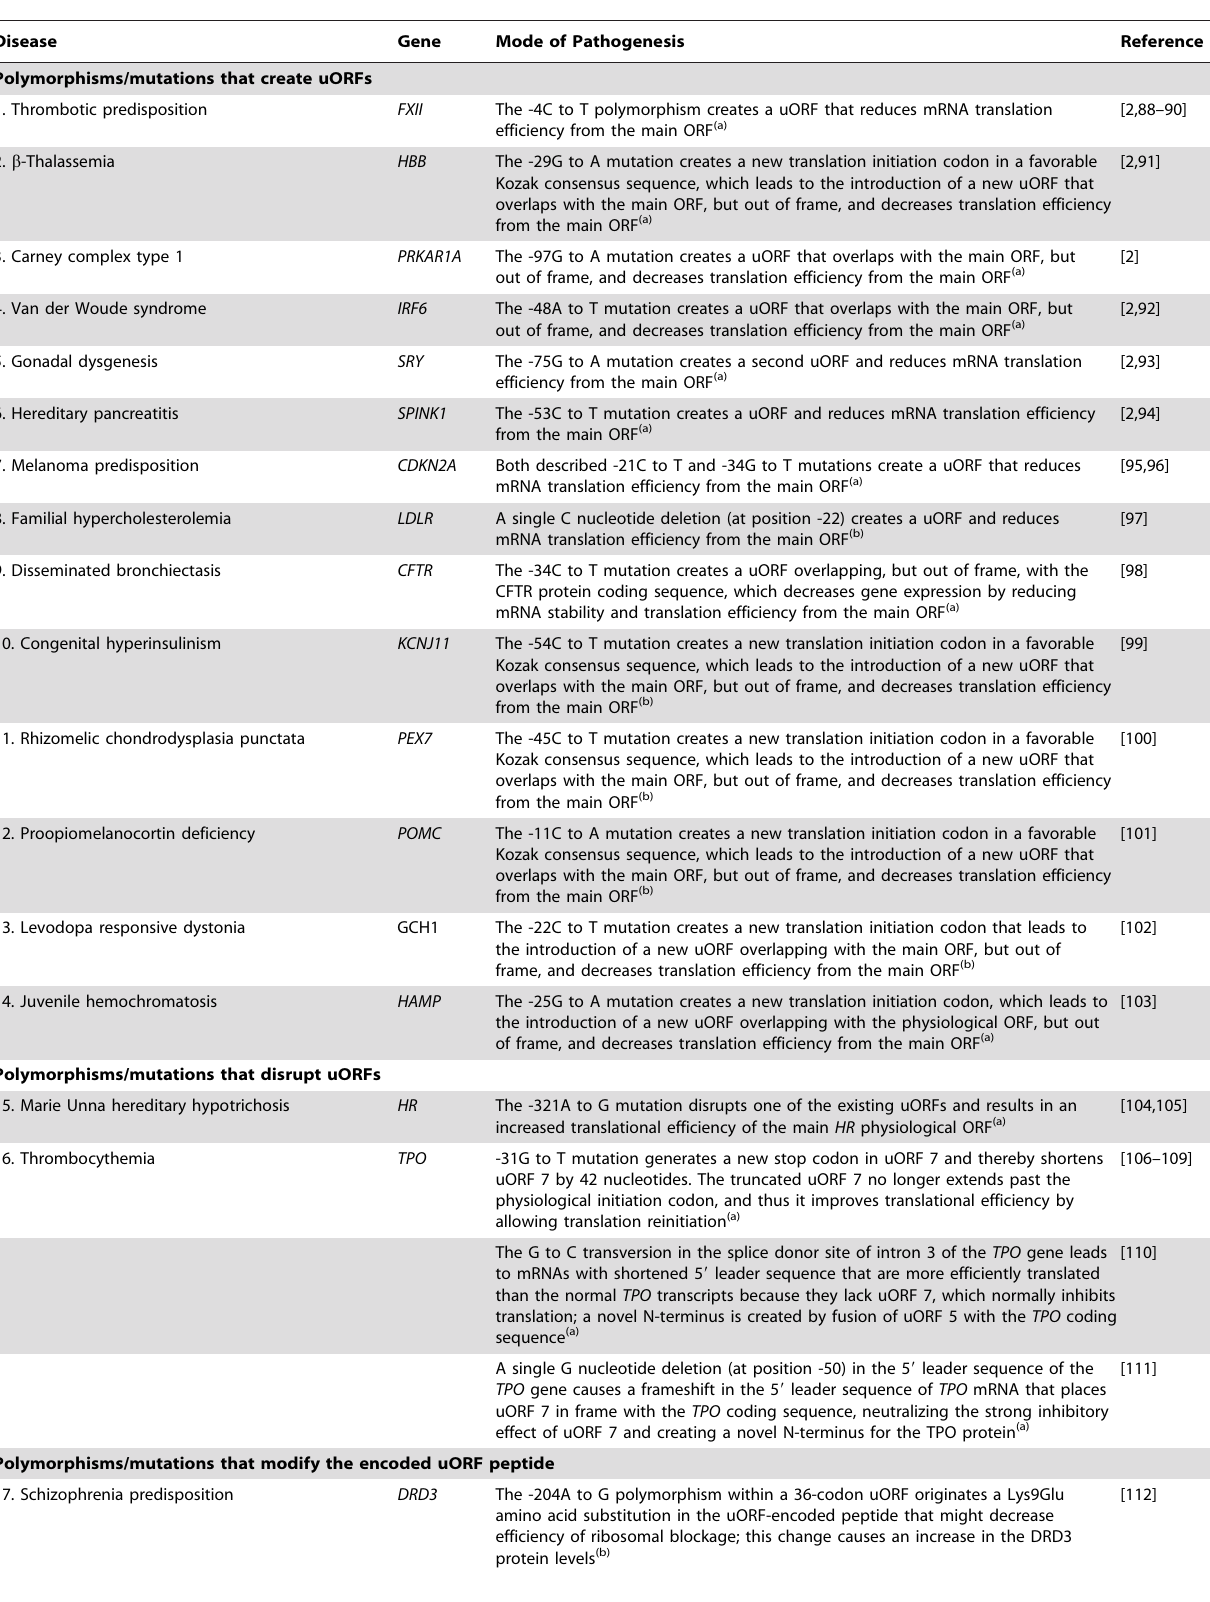
Table 1. Examples of human diseases associated with polymorphisms or mutations that introduce/eliminate uORFs or modify the encoded uORF